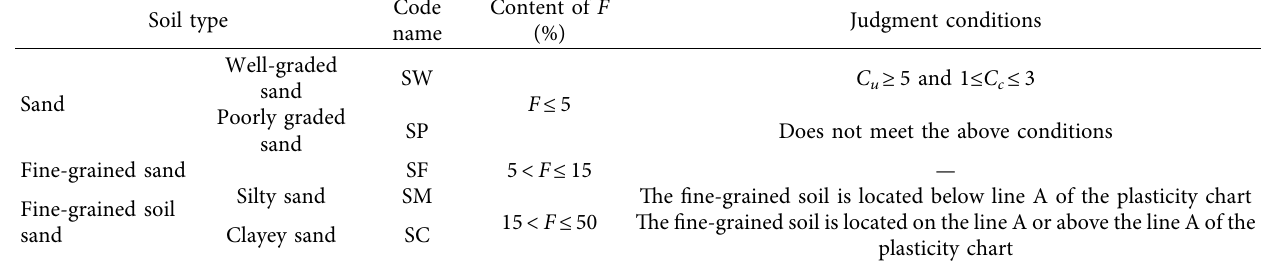
Table 1: Classification of the sandy soils.